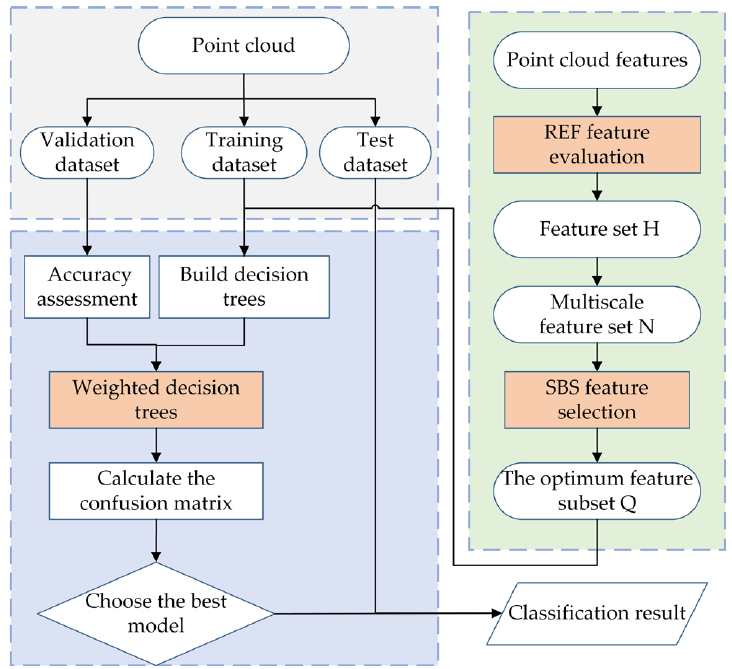
Figure 5. Improved Random Forest model.